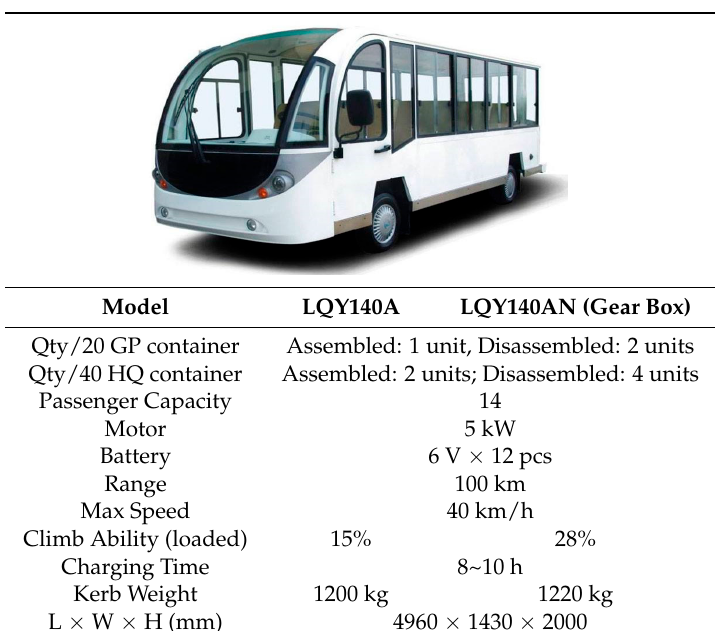
Table 1. Characteristics of the bus.